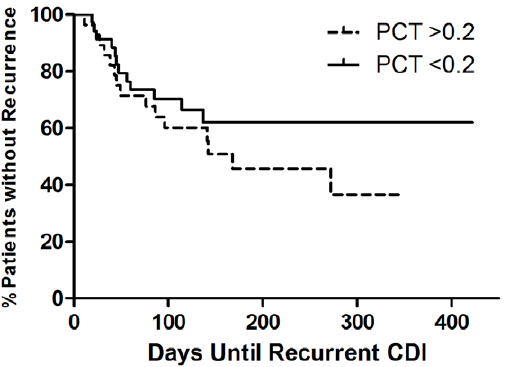
Figure 5. Kaplan-Meier Curve for Recurrence by PCT group. This curve shows a higher recurrence rate for those with PCT . 0.2 ng/mL but the hazard rate was not significant (HR 1.57, 95% CI 0.7–3.4, P